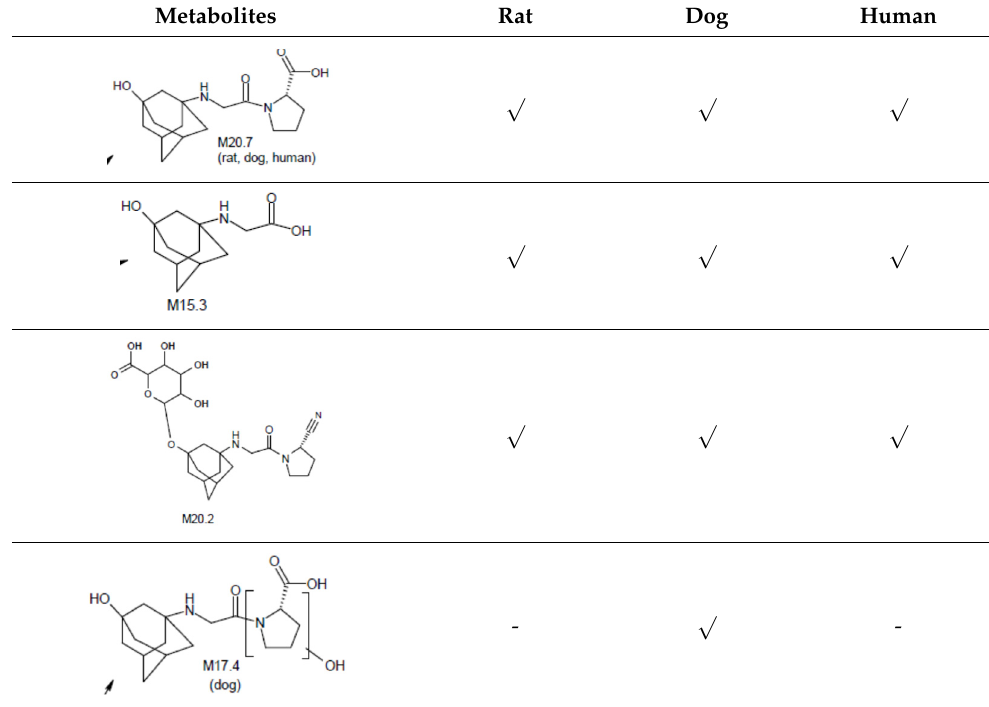
Table 2. Metabolites of vildagliptin in rats, dogs and humans.